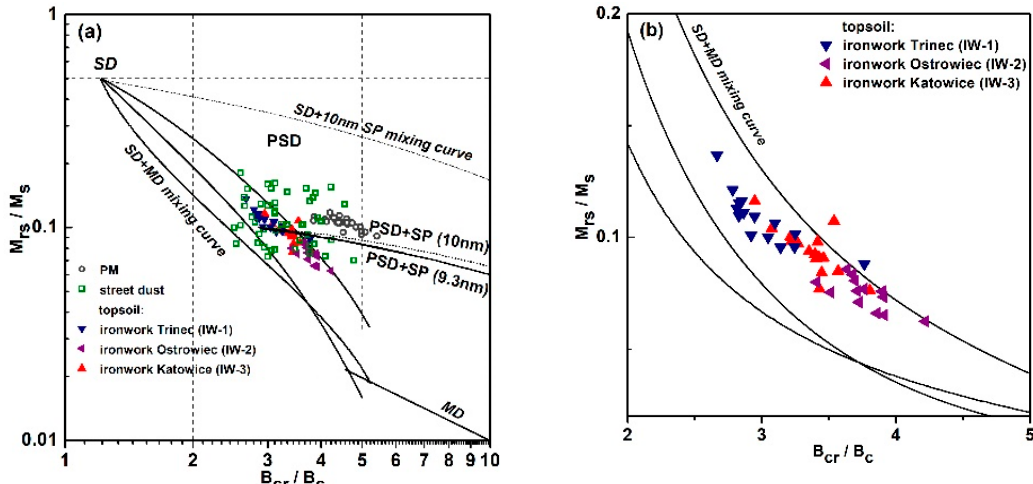
Figure 8. The M rs / M s and B cr / B c ratios on the Day–Dunlop plot ( a , b ): green open squares for the street dust from Warsaw, black open circles for the atmospheric PM10 from Warsaw, blue triangle for T ř inec ironworks (IW-1), purple triangles for Ostrowiec ironworks (IW-2), and red triangle for Katowice ironworks (IW-3). The single-domain (SD), pseudo-single-domain (PSD), and multidomain (MD) regions are marked after Day [42]. The theoretically calculated mixing curves for SD + MD, for magnetite, are marked after Dunlop [43,44].